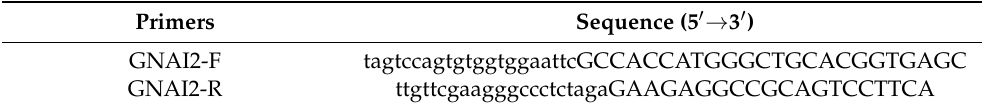
Table 1. The primer sequences of GNAI2